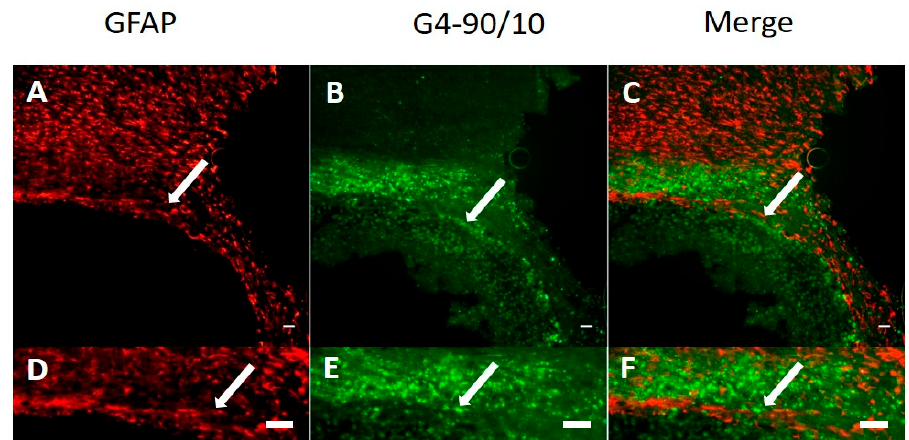
Figure 11. ( A ) Glial cells stained with Glial fibrillary acidic protein (GFAP) antibody (red; see arrow); ( B ) uptake of G4-90/10 dendrimers by the glial cells especially in the corpus callosum 1-week post-intracranial transplantation (arrow); ( C ) Co-localization between GFAP and dendrimers showing uptake of dendrimers by the glial cells (arrow); ( D – F ) show the zoomed images of ( A – C ), respectively, at the corpus callosum region. Arrow in D shows glial cells expressing GFAP; arrow in E shows uptake of G4-90/10 dendrimers by the glial cells and arrow in F shows co-localization between the dendrimers and GFAP staining that confirms the uptake of dendrimers by glial cells. This proves that the migrating cells are the glial cells that have taken up the dendrimers. Images ( top panel ) were taken at 20× magnification using Zeiss Observer inverted Microscope (Zeiss, Oberkochen, Germany). Scale bar: 100 μ m.